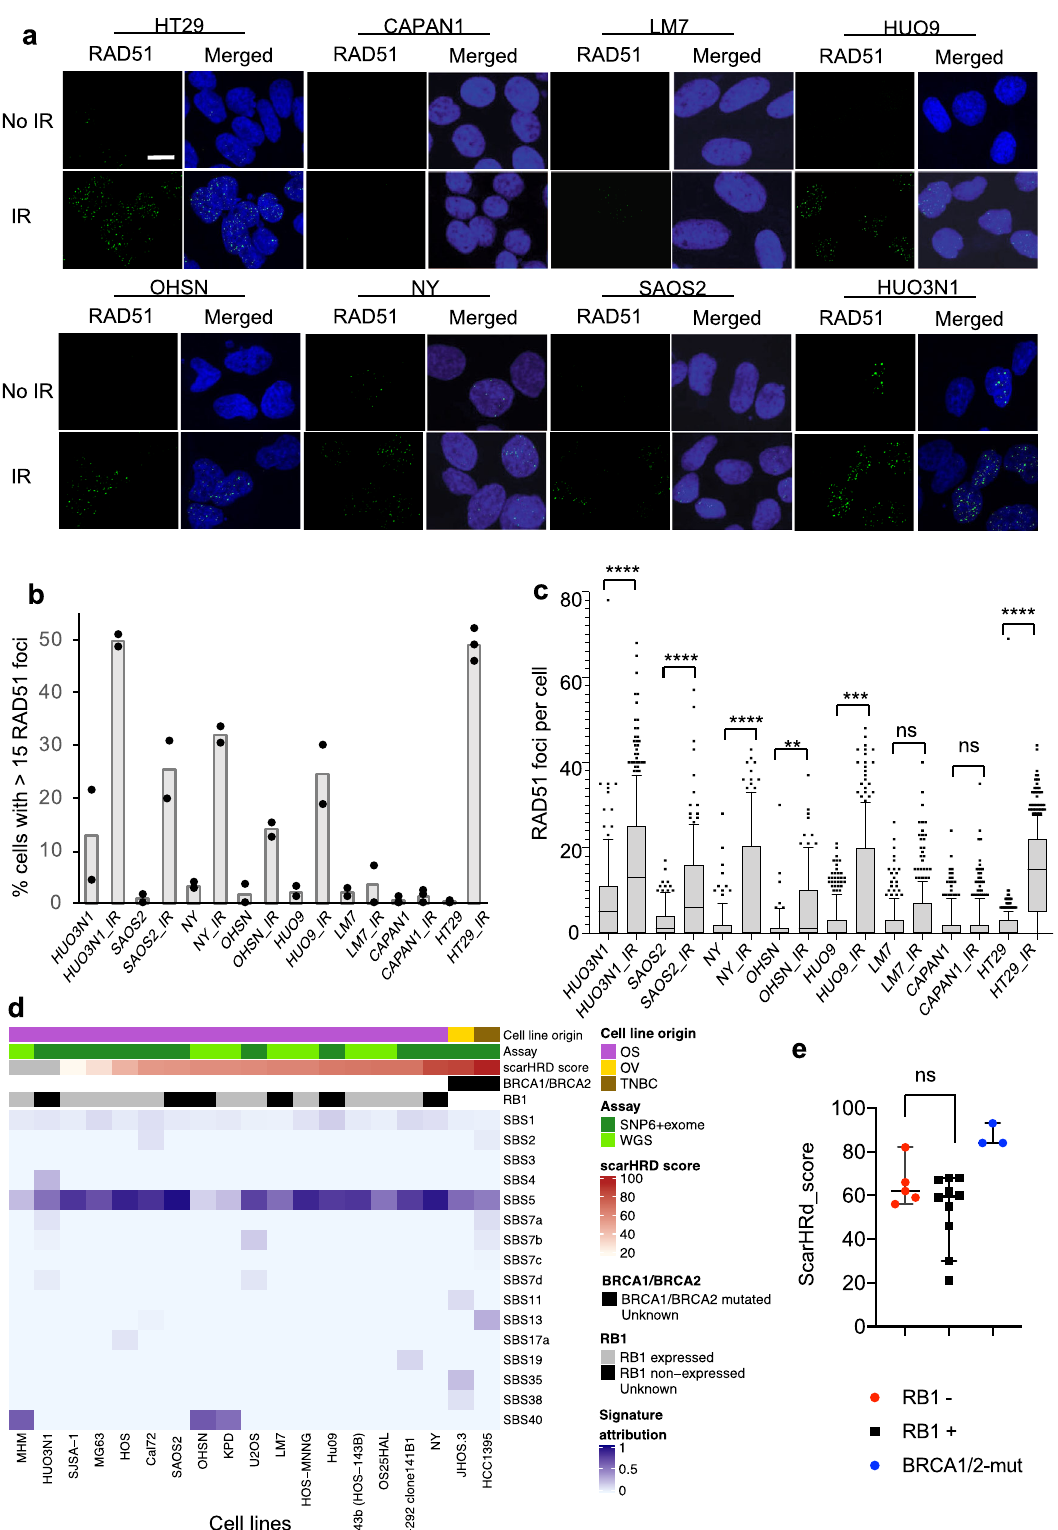
replication during olaparib treatment (Fig. 8a). Subsequently, we quanti fi ed cell death measuring SYTOX TM death-dye uptake using time-lapse imaging. OHSN cells treated with olaparib whilst under thymidine-induced DNA replication block showed a striking,